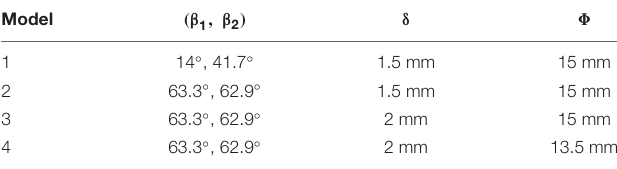
TABLE 2 | Design variables and variations.